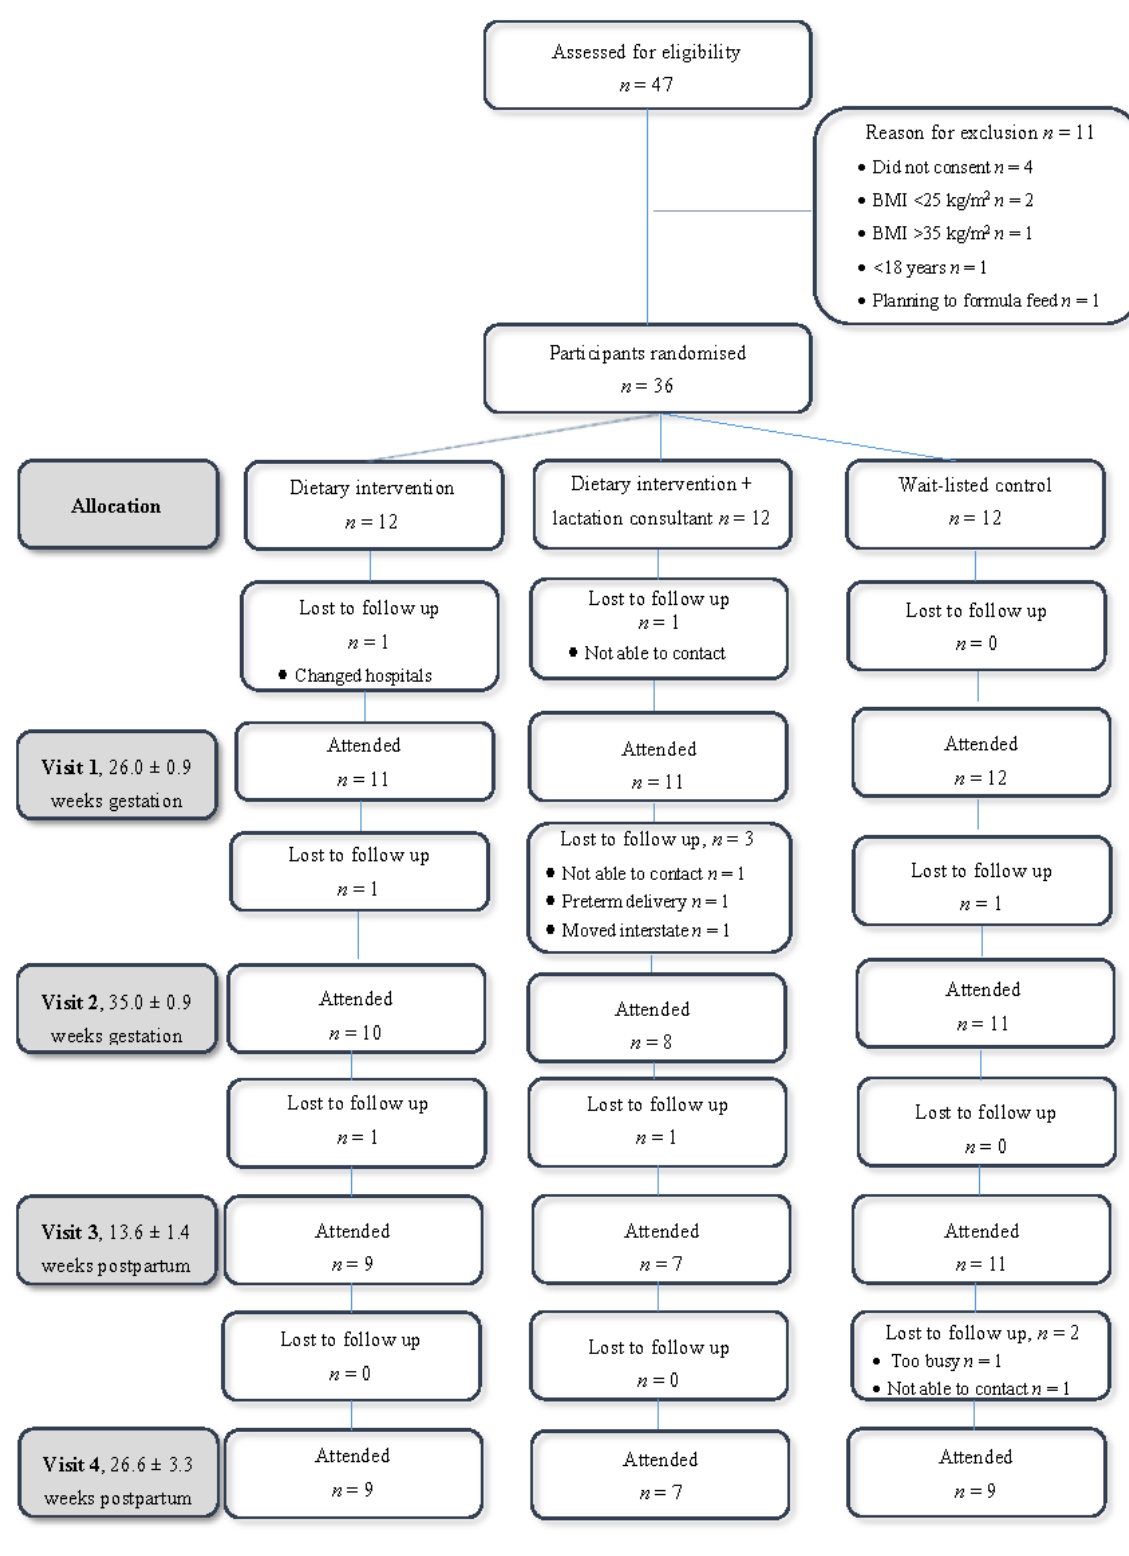
Figure 1. Flow diagram of recruitment and randomisation for a pilot randomised controlled